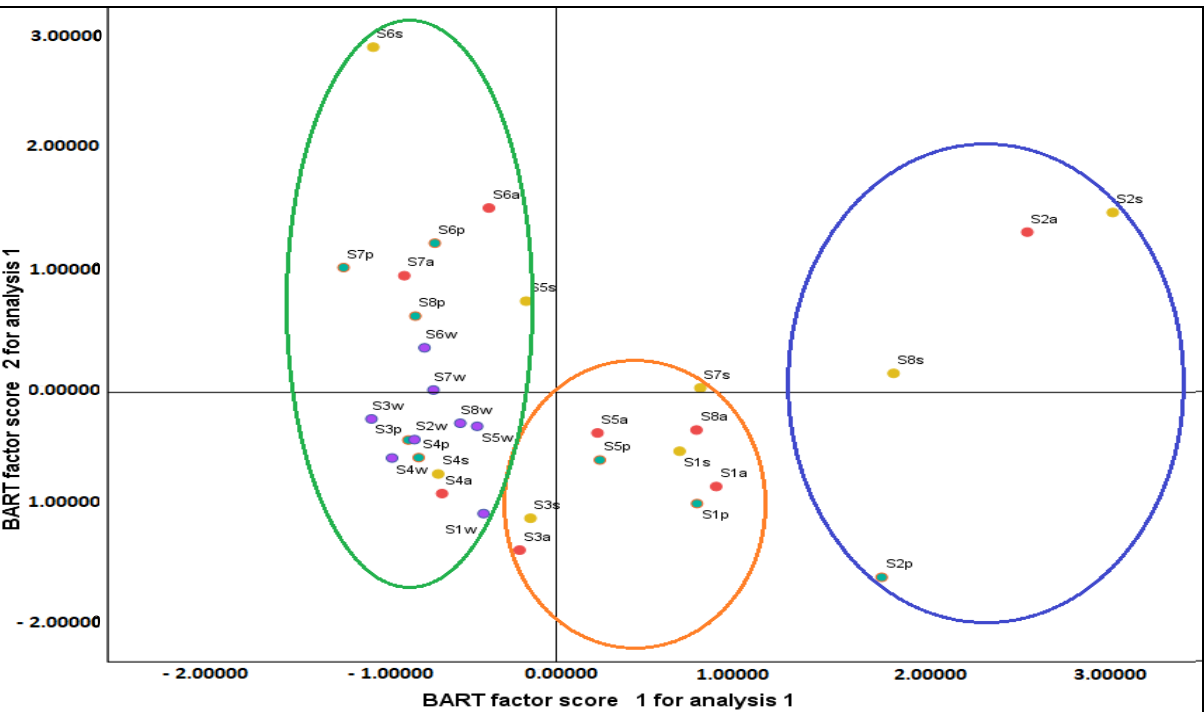
Figure 4. Score of stations using axis 1 and axis 2.